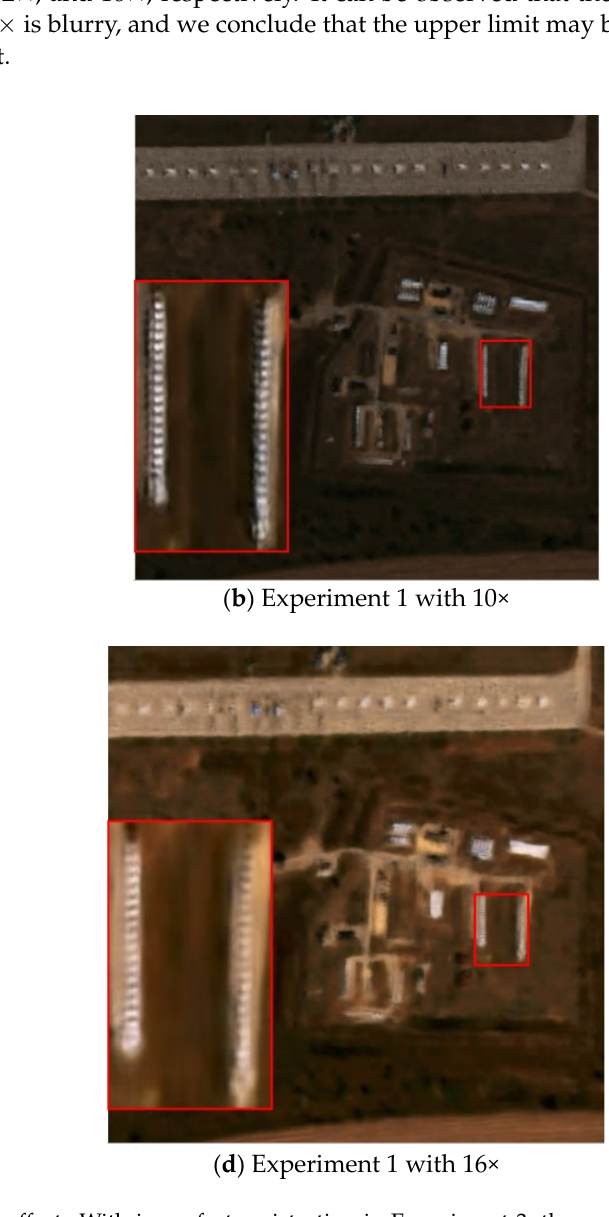
Figure 9. Visual comparison for high-frequency details of images fused by the U-Net (Figure 9 ( a )) and HRNet backbones (Figure 9 ( b )). For this experiment we choose Experiment 1 with 6×. The large red box contains the zoomed-in region in the small box.